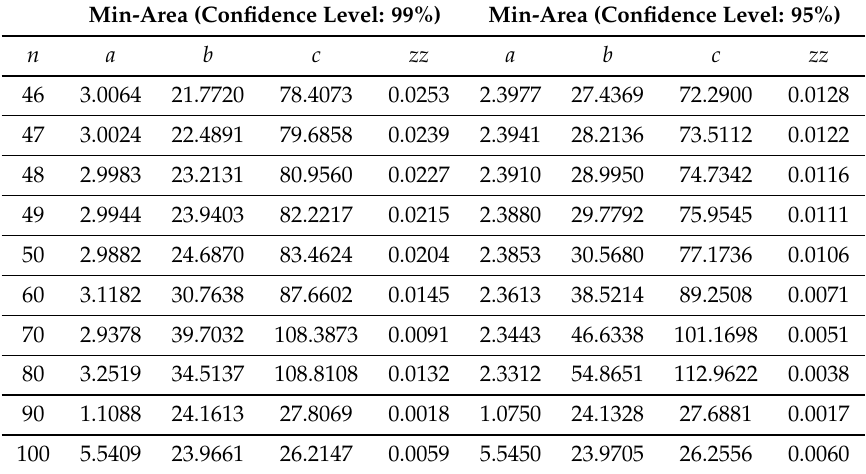
Table 5. Minimizing area method (confidence level is 99% and 95%).